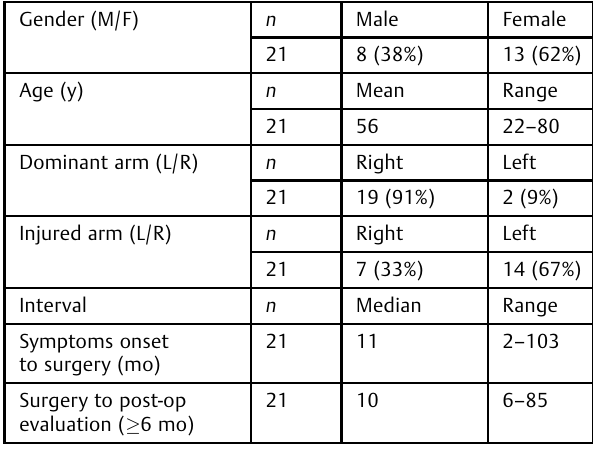
► Table 6 summarizes MRC muscle scale grades, before and after surgery. More patients demonstrated an MRC grade (cid:3) 3